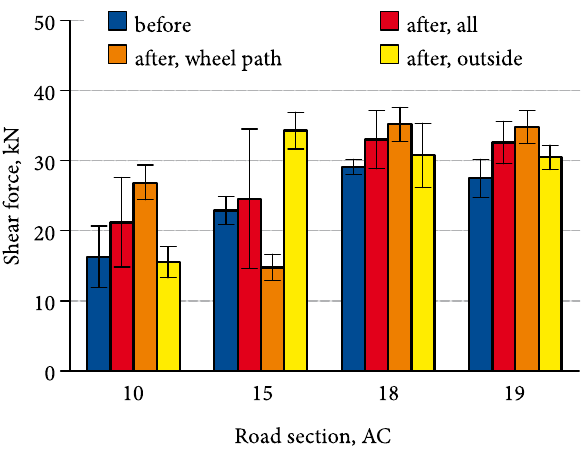
fig. 3. Comparison of shear forces at 20 °C directly after construction and after several years of traffic for all road sections with AC surface